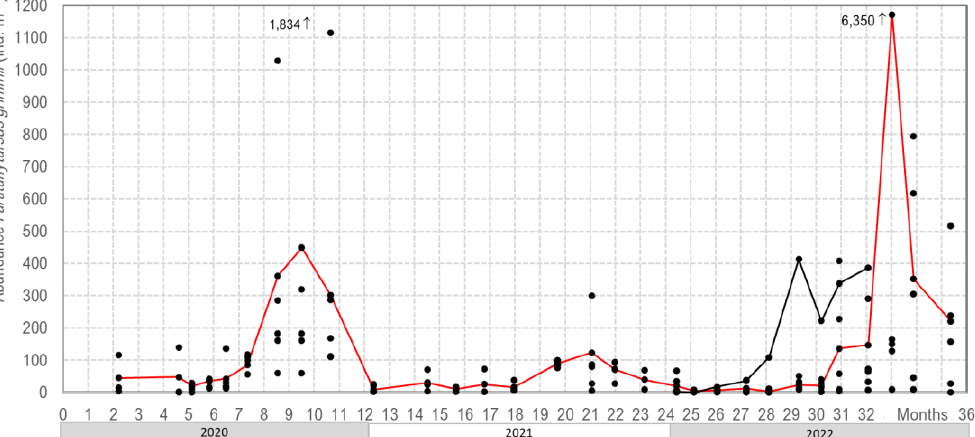
Figure 6. Our monitoring of the abundance of Paratanytarsus grimmii in a drinking water distribution system in Northern Germany (the red line shows the mean of six hydrant water samples, and the black points represent the individual monitoring data).